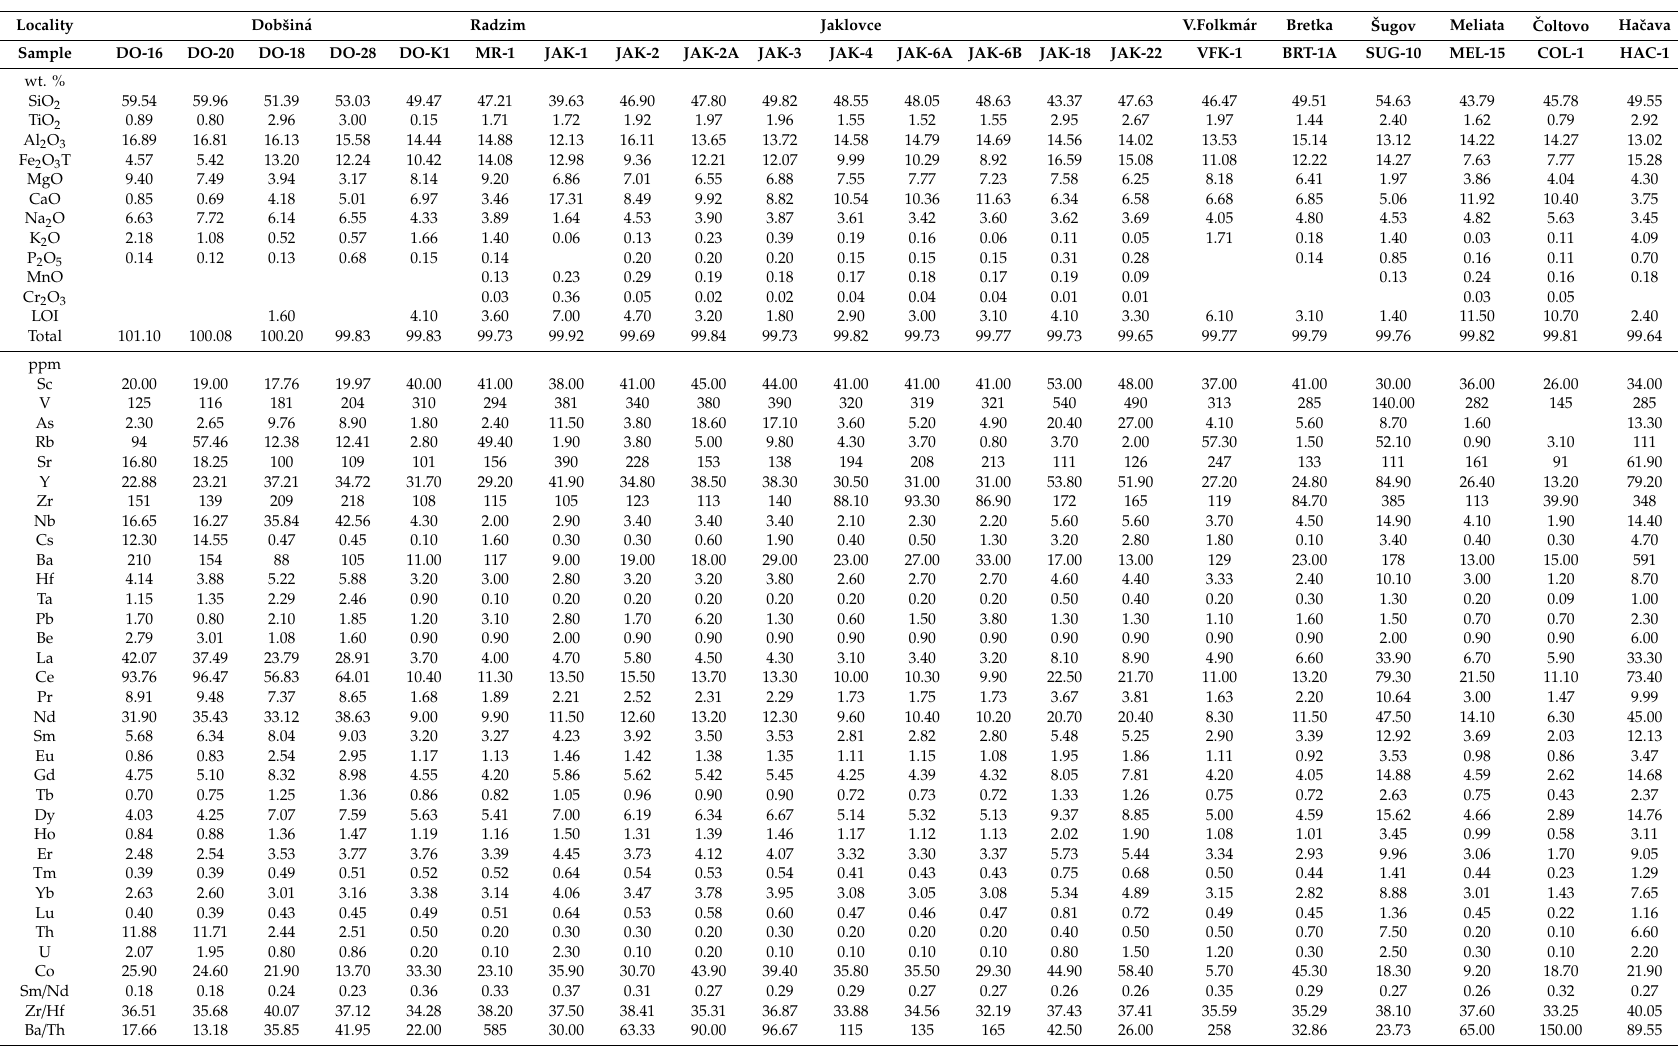
Table 1. Major and trace elements from the whole-rock XRF and inductively coupled plasma mass spectrometry (ICP–MS) analyses. LOI = Loss on ignition. Locality Dobšin á Radzim Jaklovce ˇColtovo Haˇcava Sample DO-16 DO-20 DO-18 DO-28 DO-K1 MR-1